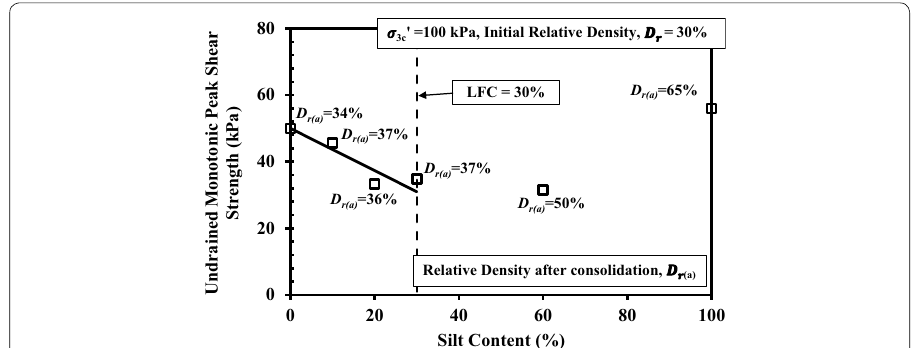
Fig. 12 Effect of silt content on undrained monotonic peak shear strenght of sand–silt mixtures at Canstant initial relative density of